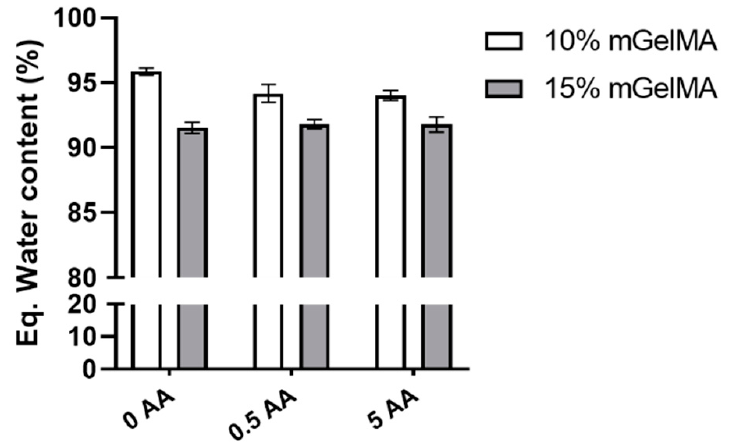
Figure 5. Water content variation at equilibrium state of 10% and 15% mGelMA hydrogels with different ascorbic acid concentrations. The values shown are means ± SD ( n = 9).